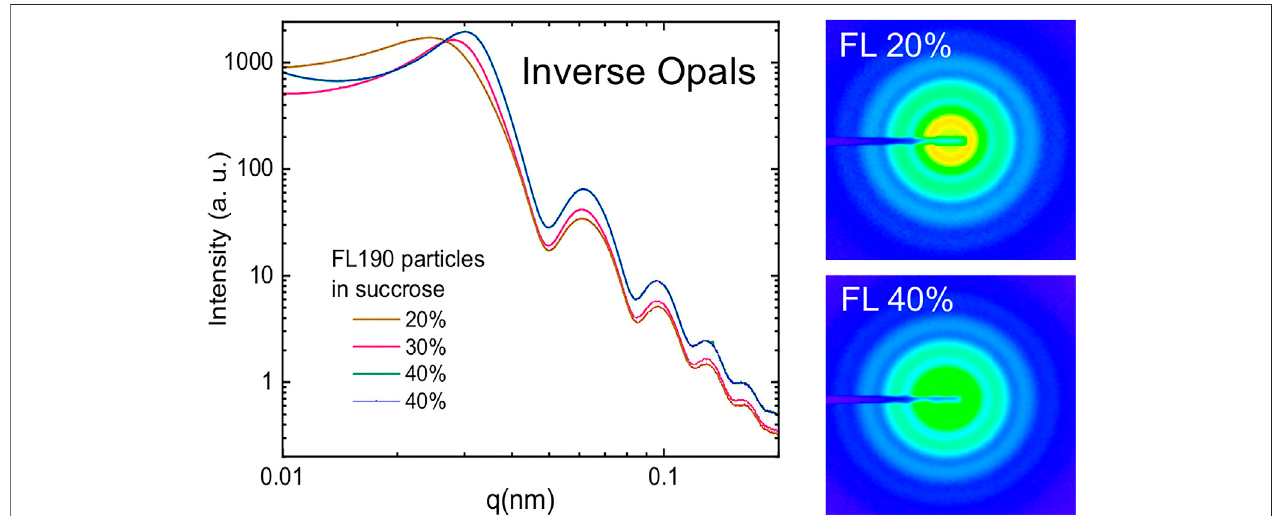
FIGURE 5 | SAXS measurements of the inverse opals taken for 3 different volume fractions. The spectra were obtained by radially integrating the 2D-spectra, shown fora20%and40%FLsampleinaqueoussucrosesolutionwitharefractiveindex n =1.4.Thetwospectrafor40%weretakenfromthesamplecapillaryshownin the Supplementary Figure S5 , but measured in different spots.